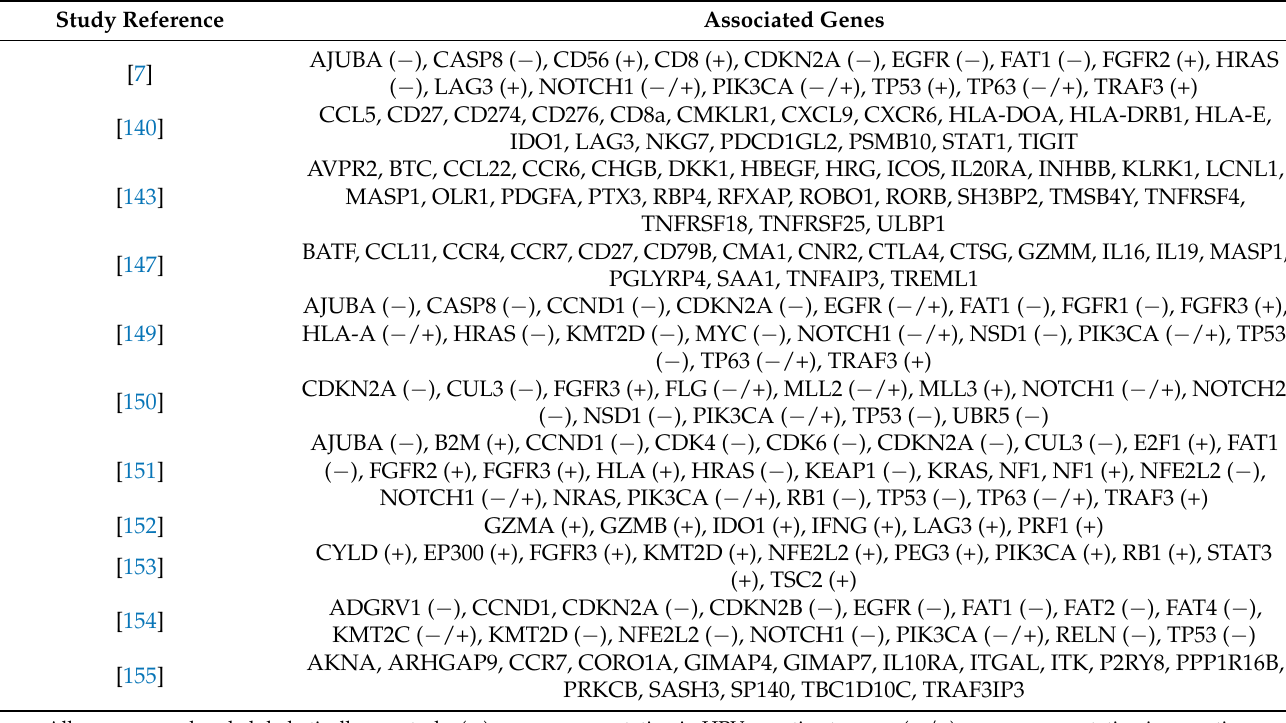
Table 2. Overview of some potential gene signatures in